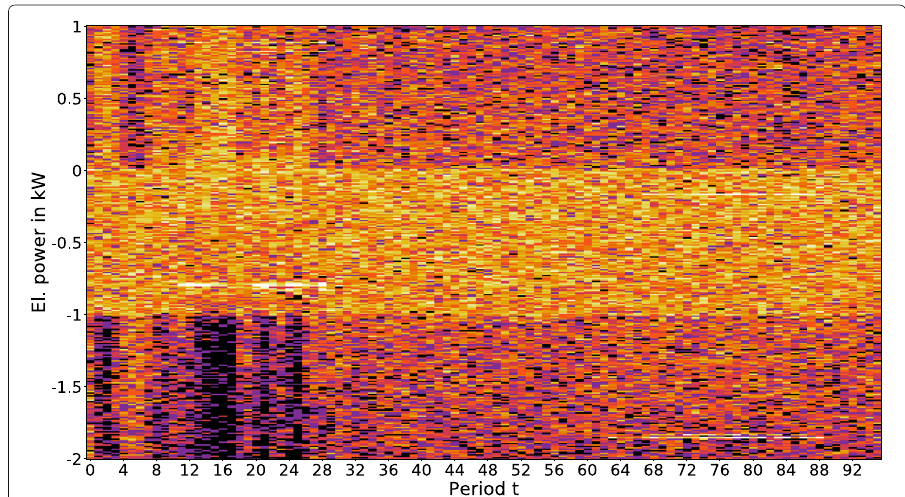
Fig. 5 Heat map indicating the coverage of all possible electric powers by the 997 generated load profiles. The more load profiles include a specific power value at a given period, the brighter the respective area. Black areas are reached by none of the 997 load